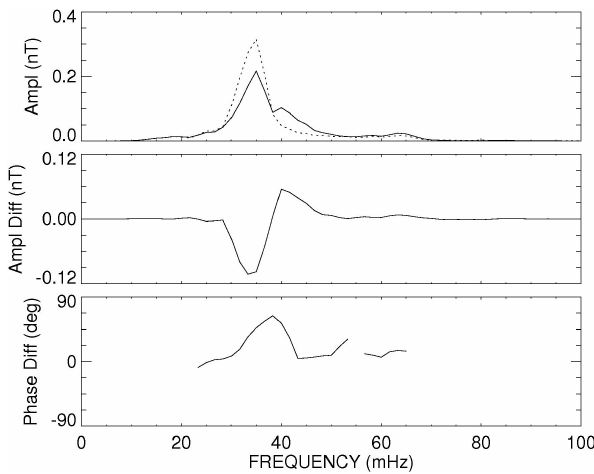
Fig. 2. The spectrum of the Pc3 pulsation H-component observed on the ground for the 12 February 2002 event that occurred between 07:25 and 07:35UTC. Top panel: Amplitude spectra at HER and SUT, Middle panel: SUT-HER amplitude difference and bottom panel: SUT-HER phase difference.